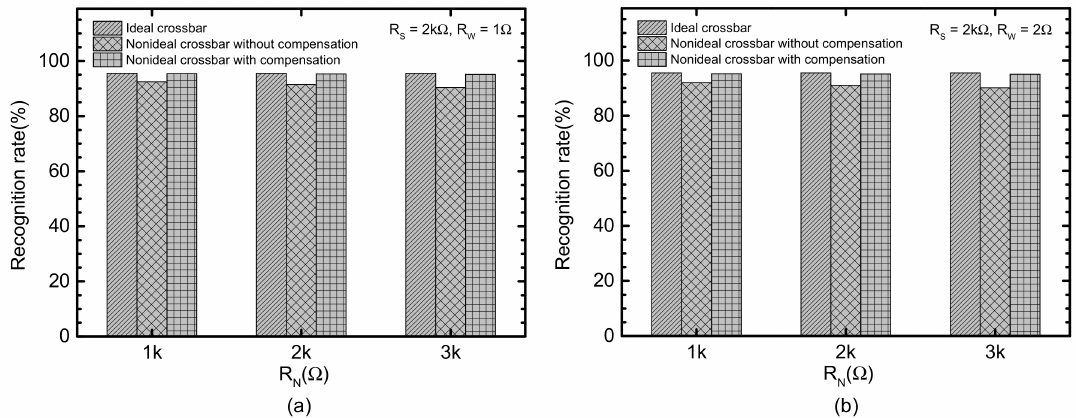
Figure 8. ( a ) Comparison of the recognition rate of the nonideal crossbars between without and with the correction circuit for MNIST data set with R W = 1 Ω , ( b ) Comparison of the recognition rate of the nonideal crossbars between without and with the correction circuit for MNIST data set with R W = 2 Ω